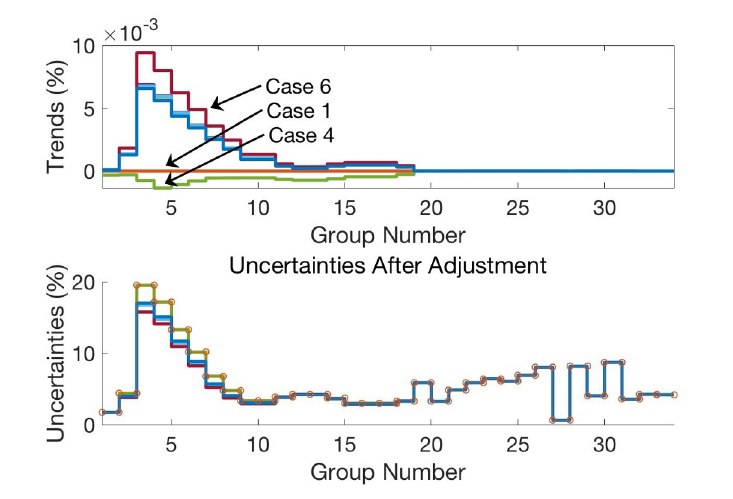
Figure 3. Adjusted Pu239 Capture data (trends and uncertainties) for all 7 sub-cases